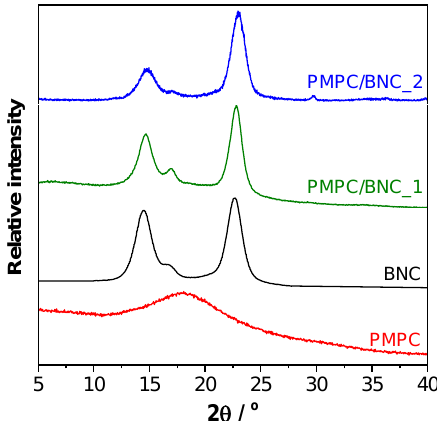
Figure 4. X-ray di ff ractograms of cross-linked PMPC, neat BNC, and nanocomposites PMPC / BNC_1 Figure 4. X-ray diffractograms of cross-linked PMPC, neat BNC, and nanocomposites PMPC/BNC_1 and PMPC / and PMPC/BNC_2.